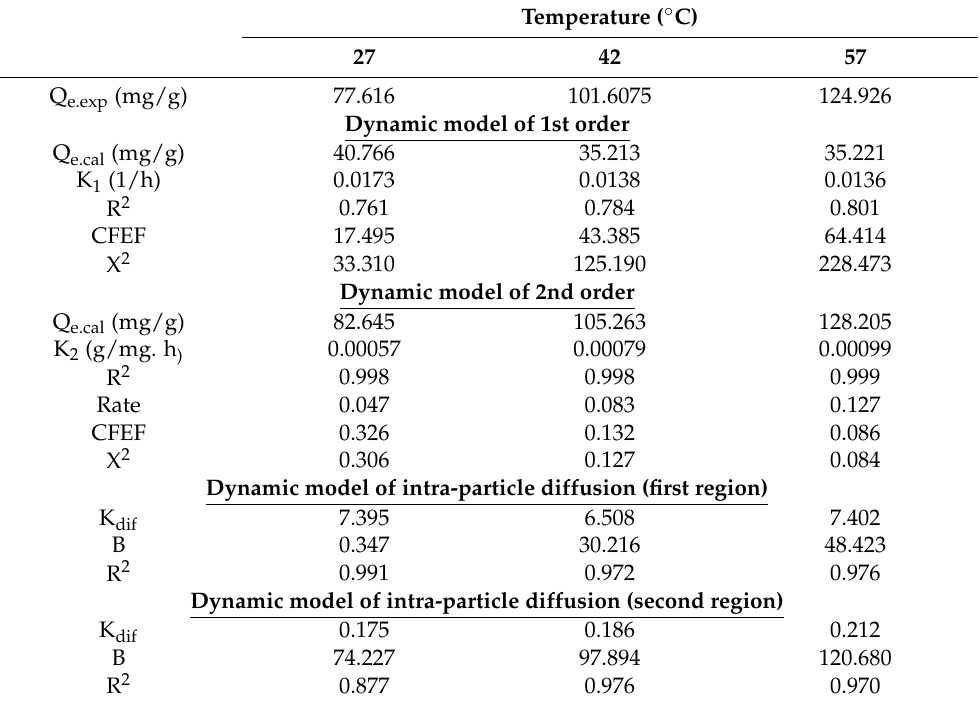
Table 3. Dynamic constant for CR adsorption onto